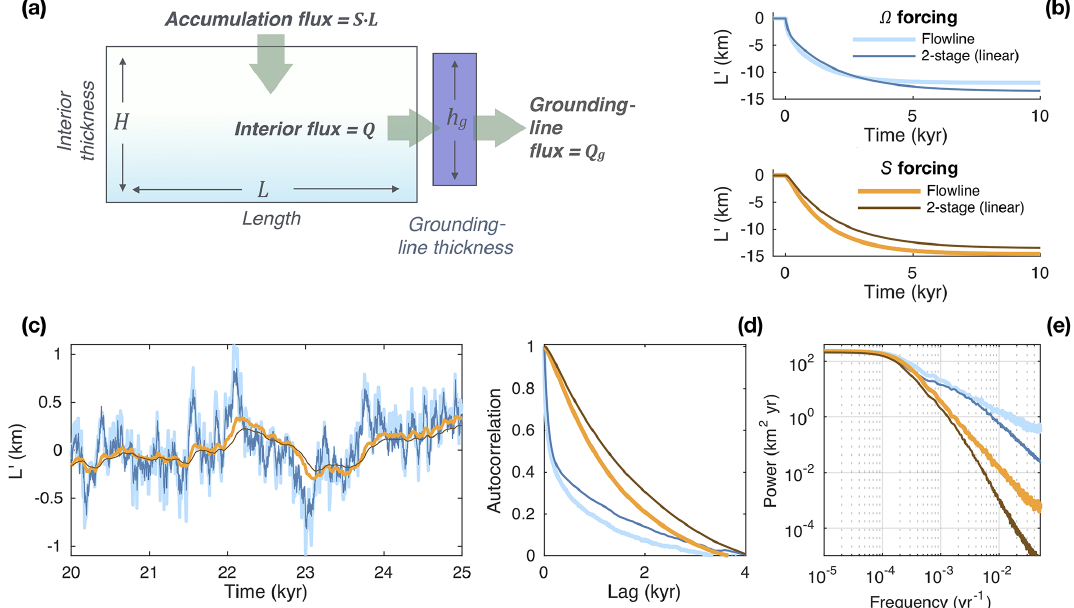
Figure 2. Comparing the transient response of flowline and two-stage models to ocean forcing (via (cid:127) ) and interior forcing (via S ). (a) Schematic of the two-stage model. (b) Flowline and linearized two-stage model length responses to step changes in (cid:127) (blues) and S (orange and brown). The thinner lines show the two-stage output. (c) Length anomalies in response to white-noise forcing in (cid:127) (blues) and S (orange and brown). As in Fig. 1, anomalies have a standard deviation of 20% of the mean value and have opposite signs. Of the 100kyr model runs, 5kyr is shown. (d) Autocorrelation function for the stochastic length fluctuations shown in (c) . (e) Power spectral density for the stochastic length fluctuations, which is estimated throughout this study via Welch’s method with windows of 1 / 16 of the time series length and 50% overlap. Note the clear split between fluctuations driven by (cid:127) (cid:48) (blues) and S (cid:48) (orange and brown) at millennial and shorter timescales. This split is robust across models. The flowline model has more high-frequency power for both types of forcing, but note that the spectral power is orders-of-magnitude lower at such high